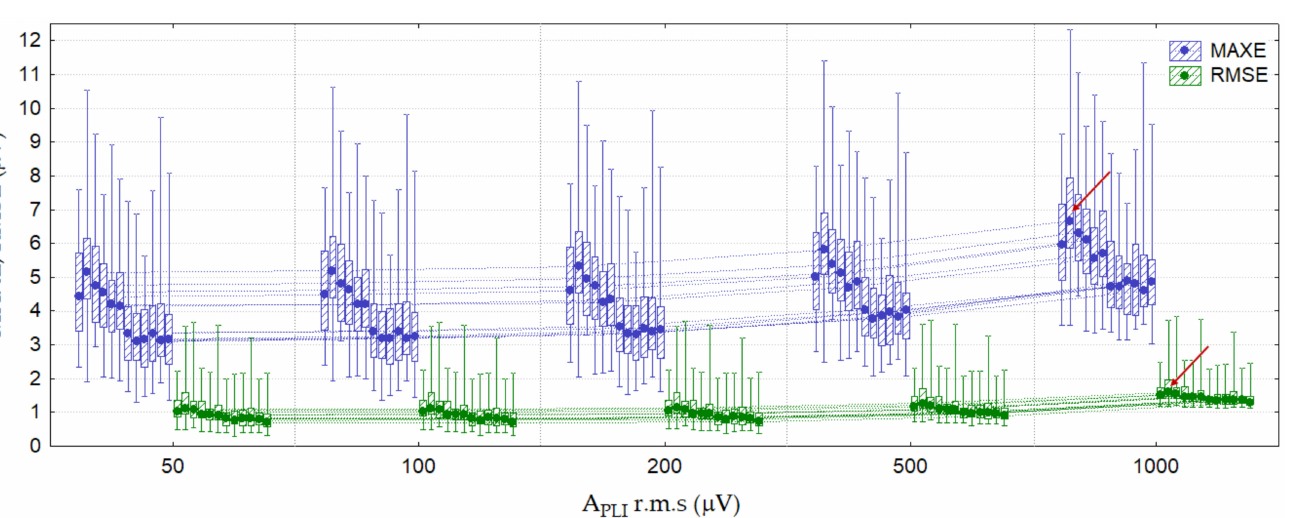
Figure 10. SF algorithm errors for PLI constant (amplitude test), computed for 10 s 12-lead ECG from the PTB Diagnostic ECG database and added PLI sinusoid with settings according to Table 2 (Test 1). The boxplots of MAXE and RMSE (median; box: 25–75%; whisker: min–max) for 12 ECG leads are ordered (from left to right): I, II, III, avR, avL, avF, V1, V2, V3, V4, V5, V6. The red arrows indicate the